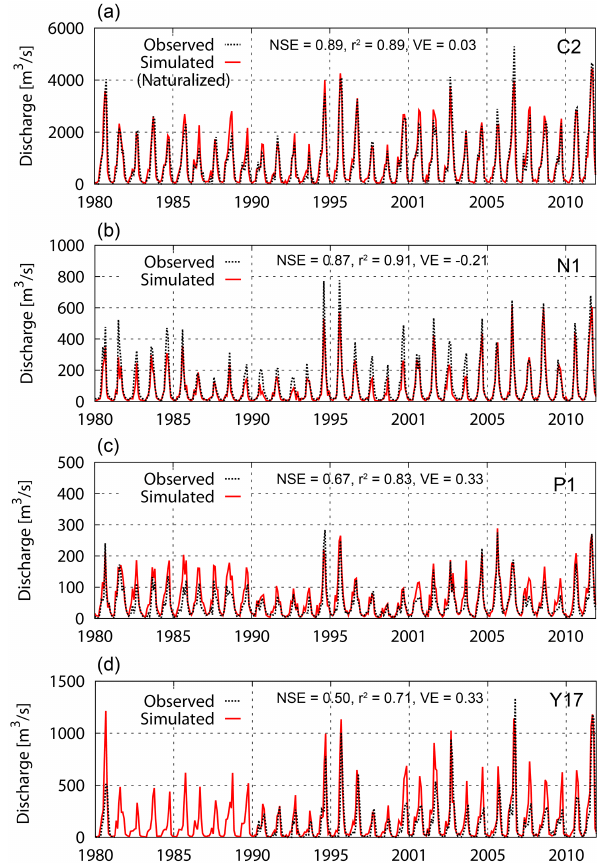
Figure 3. Simulated and observed monthly averaged river dis- charges at (a) C2 (naturalized), (b) N1, (c) P1 and (d) Y17 (ob- served records were not available between April 1981 and March 1990 at Y17). Note that C2 discharges are naturalized by excluding the effect of the two dams, while N1 and P1 are located upstream of the dams and Y17 at a different tributary. The model performance is evaluated by NSE, r 2 and VE for the period of 1980–2011.